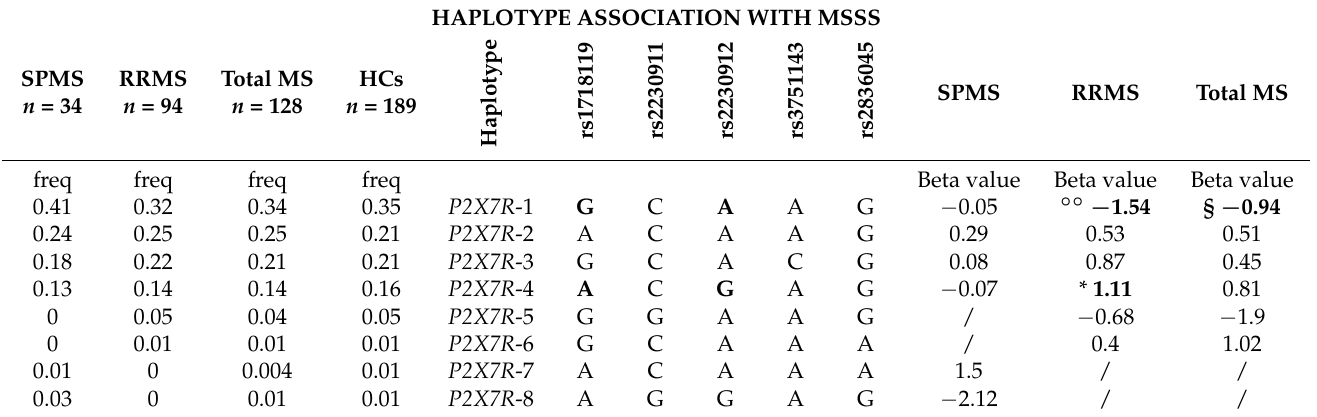
Table 3. P2X7R SNP frequencies (freq) of haplotype distribution in total MS patients, MS patients with secondary chronic progressive disease course (SPMS), MS patients with relapsing–remitting MS (RRMS), and healthy controls (HCs). Haplotype association with multiple sclerosis severity score (MSSS) values in total MS patients, RRMS, and SPMS subgroups was reported by Beta value. * p = 0.04; ◦◦ p < 0.001; § p = 0.01. Statistically significant associations are marked in